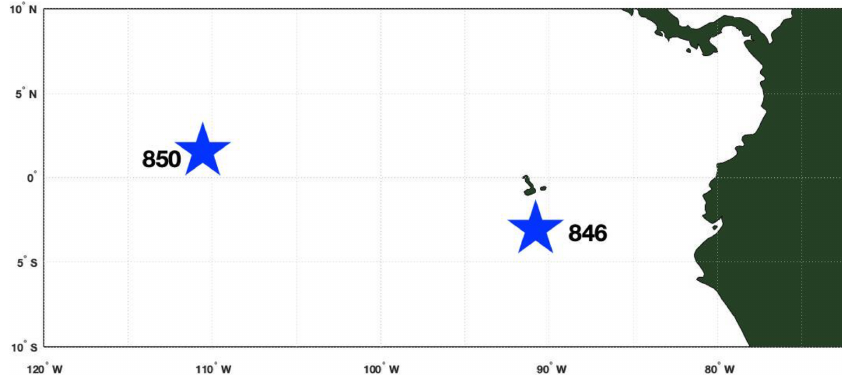
Figure 1. Locations of ODP sites 846 and 850 (ODP Leg